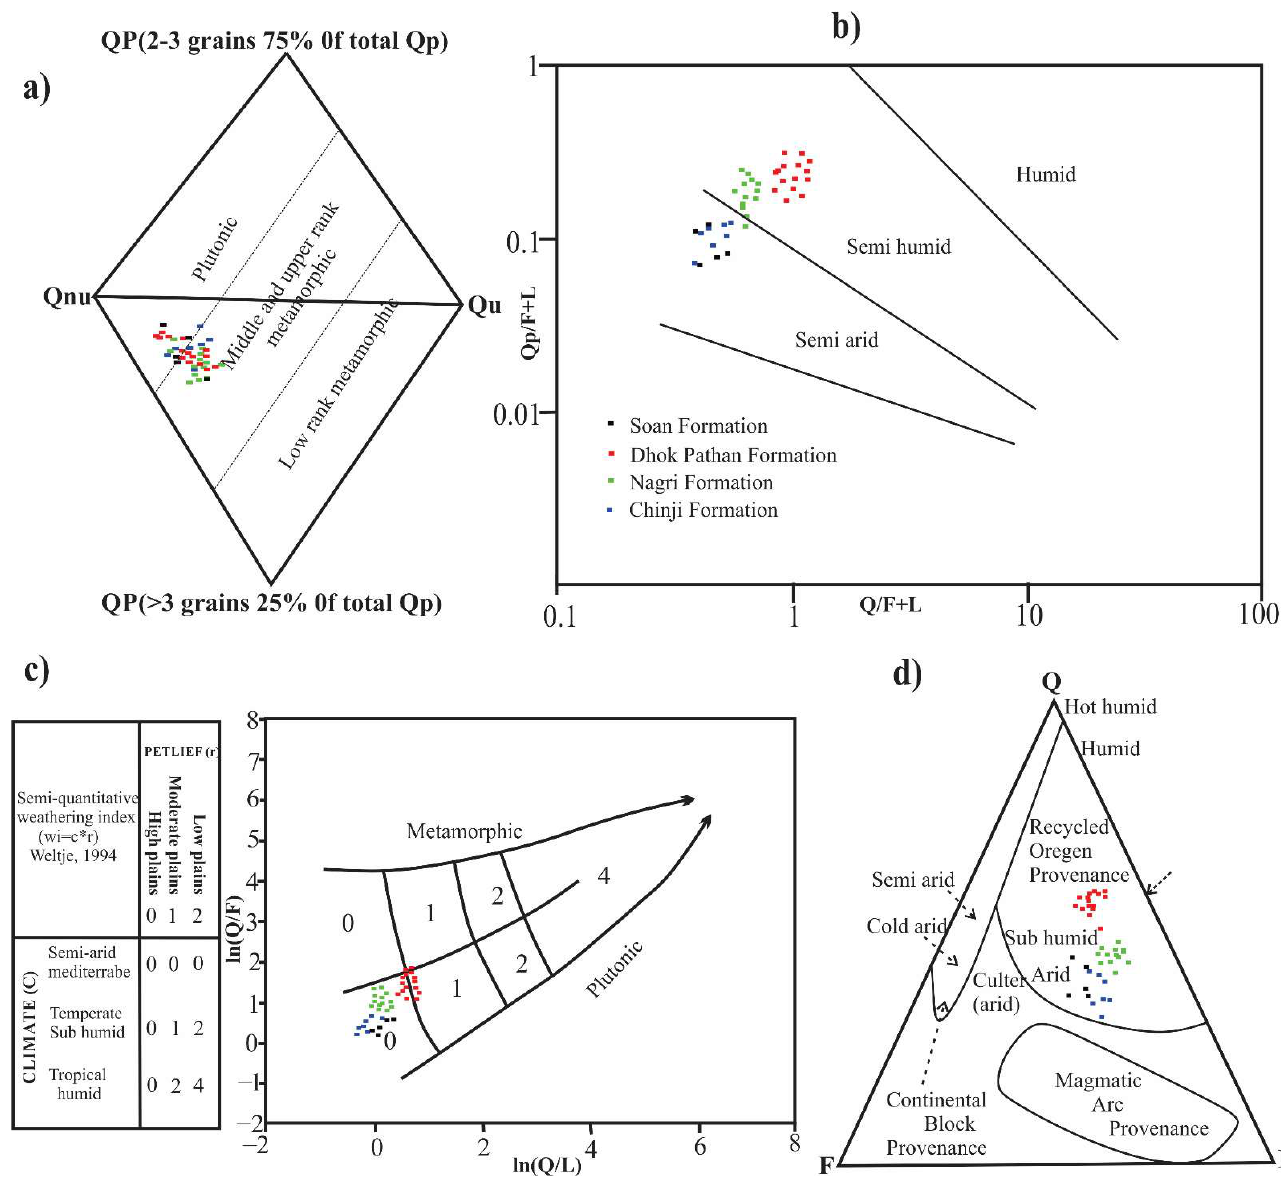
Figure 10. Diagram ( a ) shows Diamond diagram for interpretation of provenance of Siwalik Group, Diagram ( b ) showing the paleoclimatic condition of the Siwalik Group and is interpreted based on the plot of the Suttner and Dutta [56] Qp/(F+RF) vs. Q/(F+RF), ( c ) Weathering diagram and semi-quantitative weathering index after Weltje (1994), ( d ) interpretation of climatic conditions from QFL ternary diagram for the sandstones of Siwalik Group.